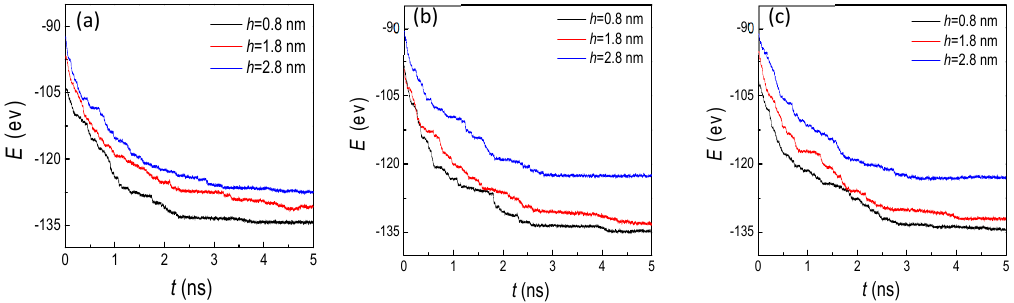
Figure 10. The potential energy between argon atoms and the cold wall with three groove heights and widths of ( a ) 1.8, ( b ) 2.4, and ( c ) 3.2 nm on hydrophobic surfaces.